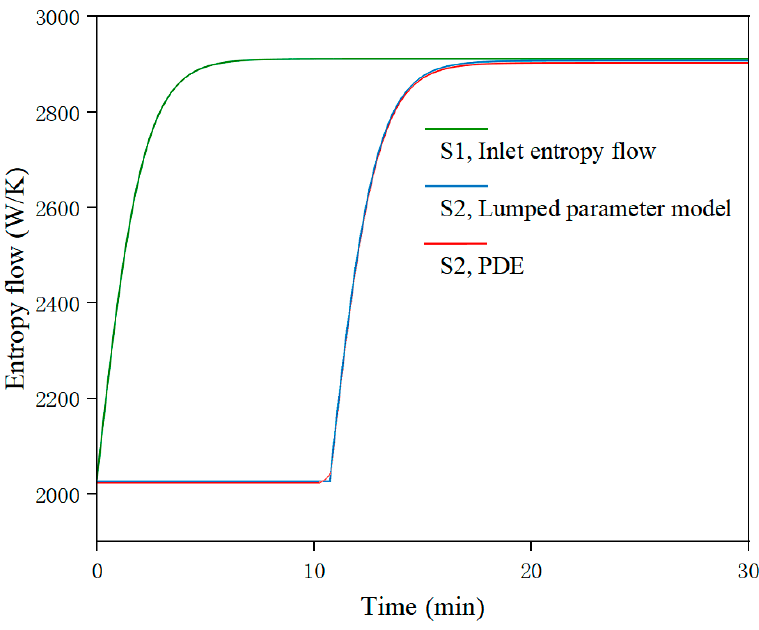
Figure 10. Temperature response of the lumped parameter entropy flow model.